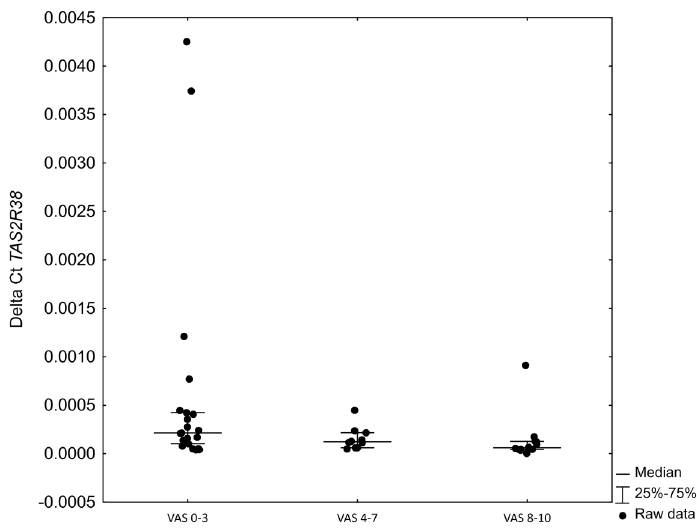
Figure 2. Level of TAS2R38 receptor expression in inferior turbinate mucosa within patient subgroups divided according to VAS scale ranges. Kruskal–Wallis’s analysis of variance p = 0.020; post hoc Dunn’s test p = 0.0158 between VAS 0–3 and VAS